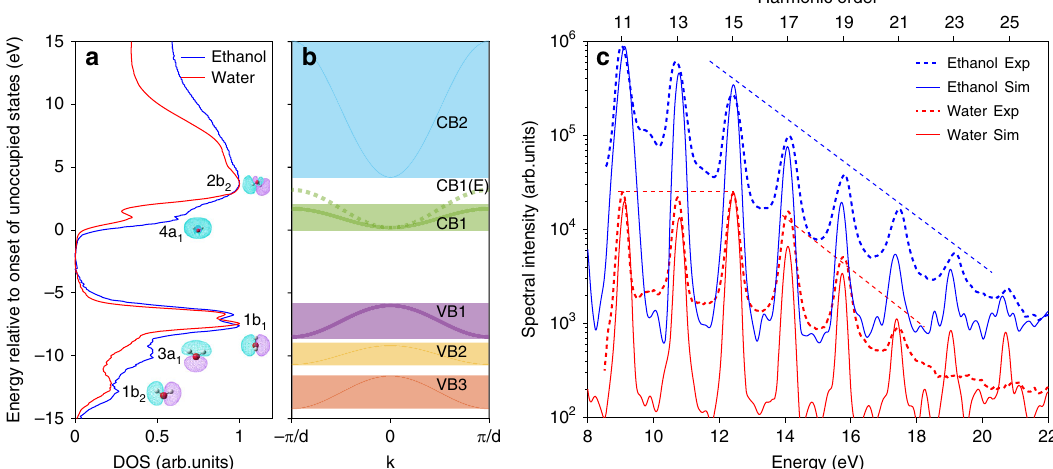
Fig. 4 Sensitivity of HHG to the electronic structure of liquids. a Density of states extracted from X – ray absorption and emission spectra of liquid ethanol and water. The assignments of the bands to orbitals of isolated molecules are shown only for water. The orbitals are displayed as corresponding insets. b Adapted model band structure used in the numerical solution of the semiconductor Bloch equations. The modi fi ed fi rst conduction band CB1(E) is used instead of CB1 in the case of ethanol. c Comparison of experimentally measured spectra (dashed curves) and calculated spectra using only the VB1 and CB1/CB1(E) (solid curves). Dashed straight lines are guides to the